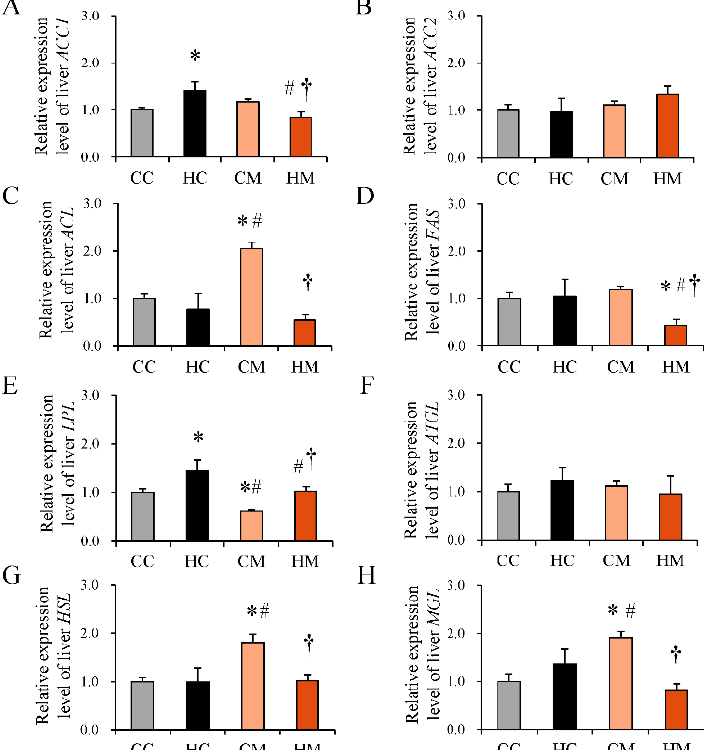
Figure 6. Messenger RNA expression of key enzymes for lipid metabolism in fetal liver. ( A ) ACC1, ( B ) ACC2, ( C ) ACL, ( D ) FAS, ( E ) LPL, ( F ) ATGL, ( G ) HSL, and ( H ) MGL mRNA expression in the fetal liver of rats fed a maternal control diet (CC), maternal high-fat diet (HC), maternal control diet with prenatal metformin treatment (CM), or maternal high-fat diet with prenatal metformin treatment (HC). The housekeeping gene was GAPDH, and mRNA expression is shown as the relative fold. * Compared to the CC group, p < 0.05; # compared to the HC group, p < 0.05; † compared to the CM group, p < 0.05. Abbreviations: ACC1, acetyl-CoA carboxylase 1; ACC2, acetyl-CoA carboxylase 2; ACL, ATP-citrate synthase; LPL, lipoprotein lipase; ATGL, adipose triglyceride lipase; HSL, hormone-sensitive lipase; MGL, monoacylglycerol lipase; GAPDH, glyceraldehyde-3-phosphate